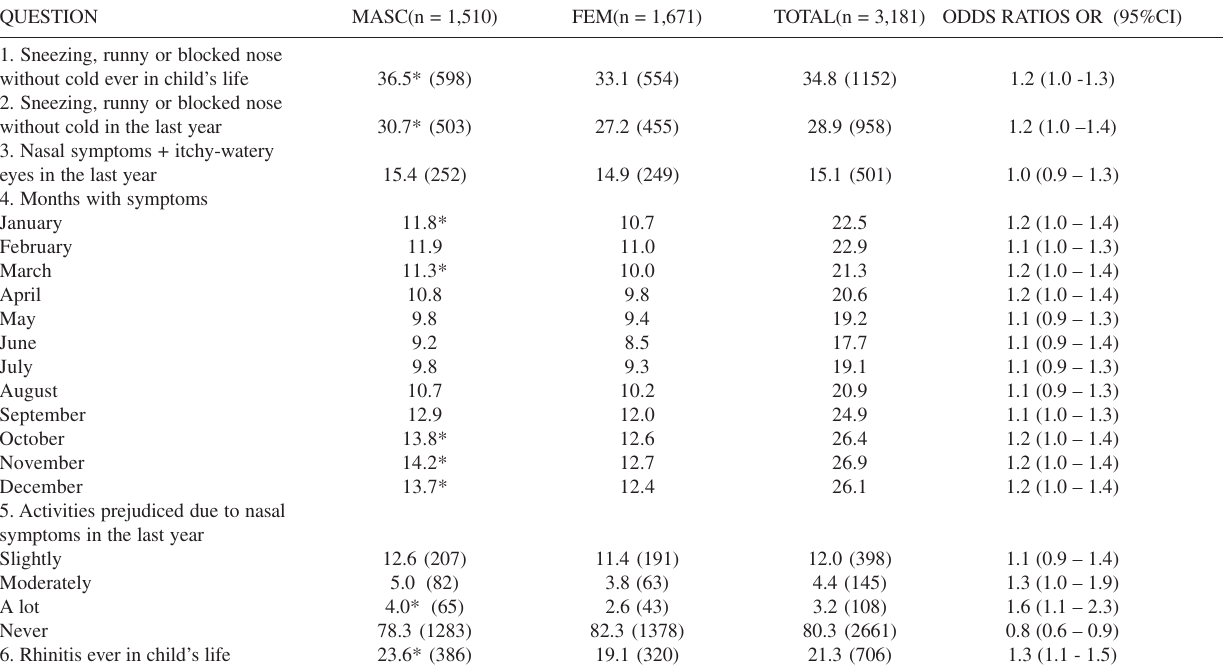
Table 2. Prevalence of rhinitis (%) symptoms, according to gender, in 3,312 6-7 year-old students from the western districts of São Paulo City #